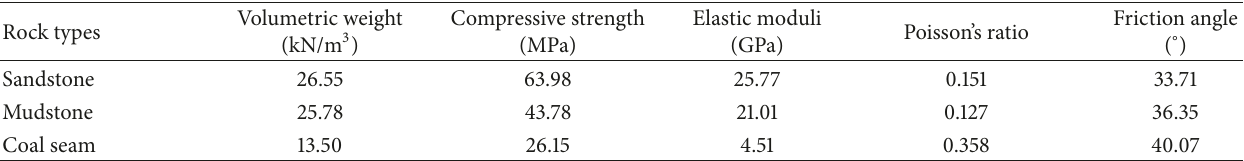
Table 1: Material properties of the real rocks.